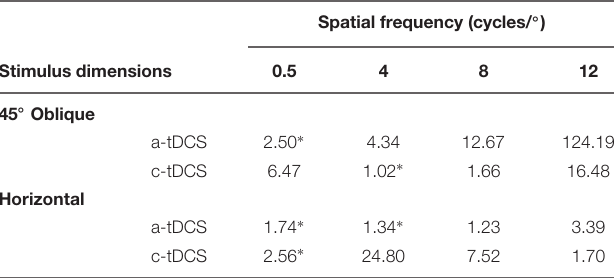
TABLE 1 | Left-Tail Ratios of contrast sensitivity measures in the fixed stimulus period